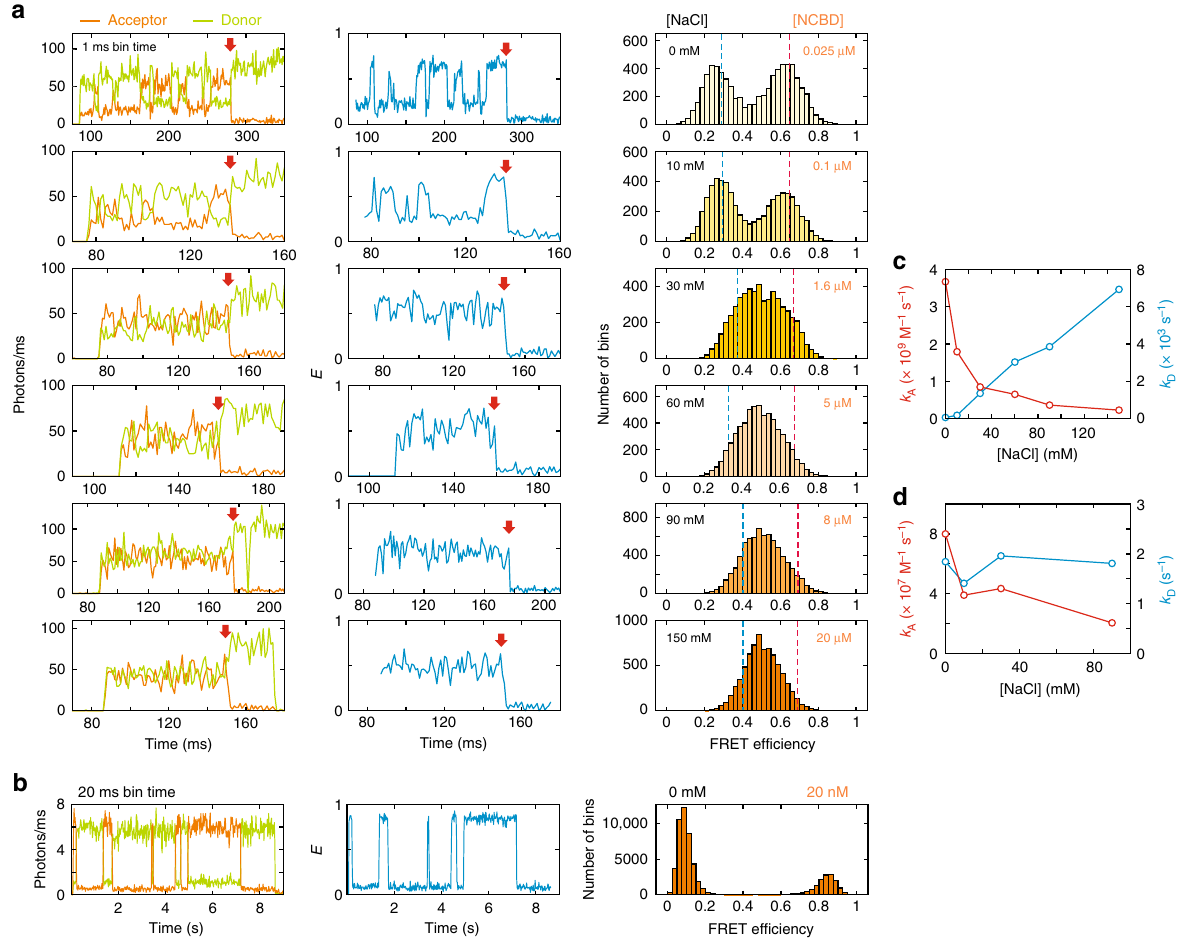
Fig. 2 Ionic strength dependence of binding kinetics. a Donor and acceptor fl uorescence trajectories (left), FRET ef fi ciency trajectories (middle), and FRET ef fi ciency histograms (right) of TAD/NCBD binding at various NaCl concentrations. Bin time is 1 ms and quoted numbers in the FRET ef fi ciency histograms are NaCl (left) and NCBD (right) concentrations. Red arrows indicate photobleaching of the acceptor. b Donor and acceptor fl uorescence trajectories (left), FRET ef fi ciency trajectory (middle), and FRET ef fi ciency histogram (right) of binding of barnase and barstar (20 nM) at 0 mM NaCl. Bin time is 20 ms. c , d Association (red) and dissociation (blue) rate coef fi cients of c TAD/NCBD and d barnase/barstar